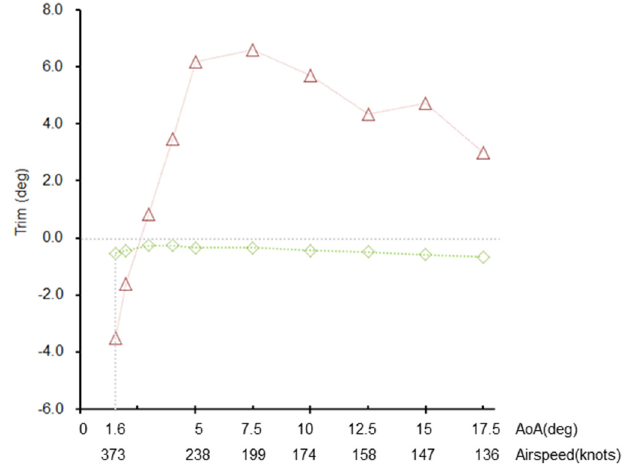
Figure 6. Required trim as a variation of airspeed and AoA to 1 g level flight in 20 Kft altitude in the asymmetric store configuration.